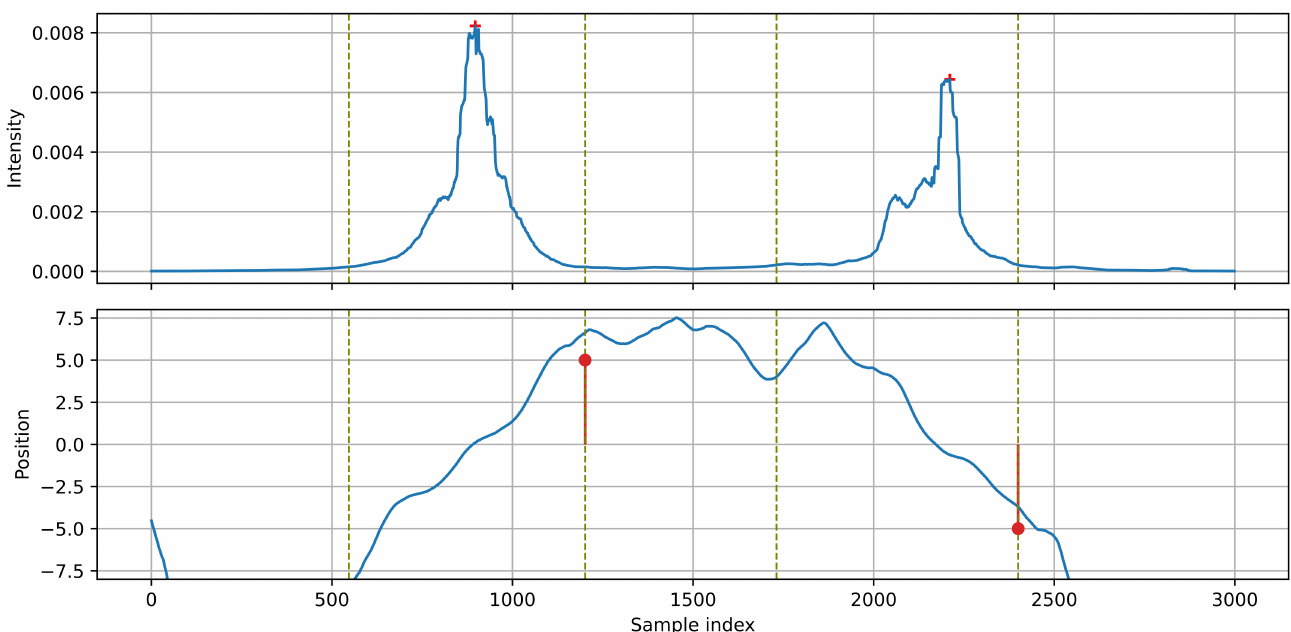
Figure 7. Example of detection: two isolated vehicles moving in opposite directions.